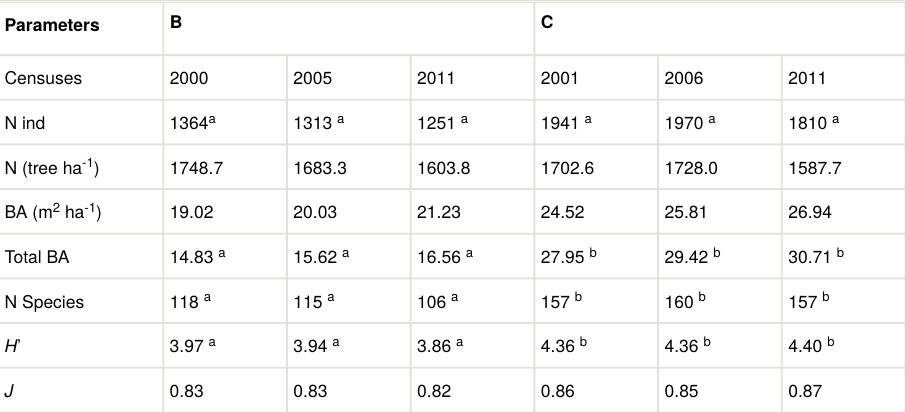
Table 2. Tree stand structure, diversity and species richness from two stands (B and C) in the Semideciduous Forest at the Parque Ecológico Quedas do Rio Bonito (PEQRB), municipality of Lavras, South of Minas Gerais State, Southeast